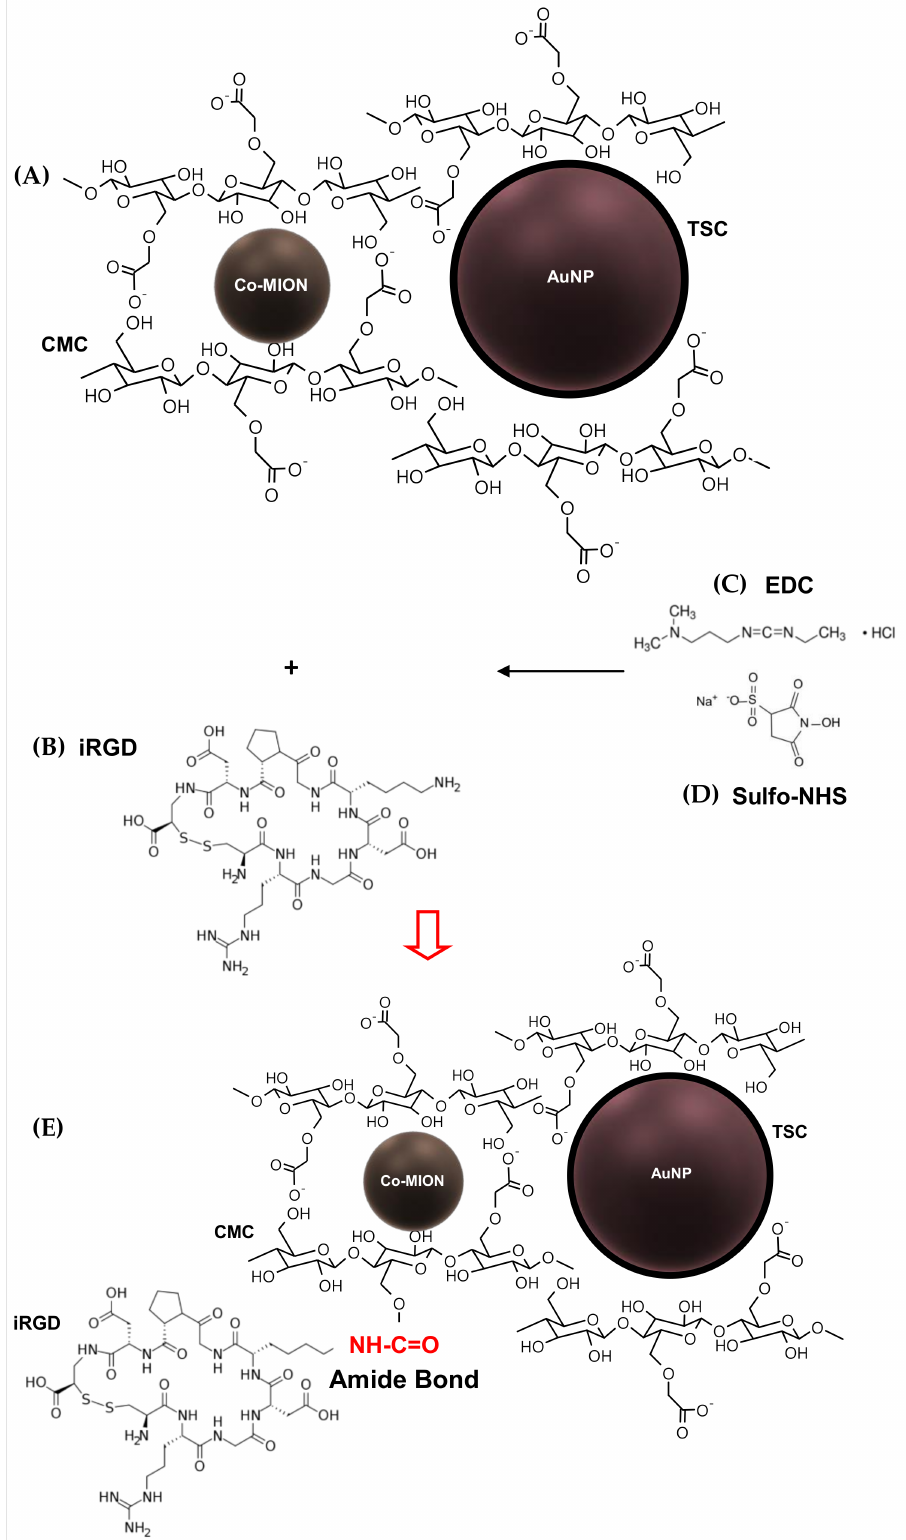
Figure 1. Chemical structure of biopolymer–peptide conjugate precursors: ( A ) inorganic–inorganic dual-nanozyme systems functionalized by a carboxymethylcellulose (CMC) biopolymer organic shell. ( B ) iRGD. ( C ) 1-ethyl-3-(3-dimethylaminopropyl)carbodiimide (EDC). ( D ) N-hydroxysulfosuccinimide sodium salt (sulfo-NHS). ( E ) active integrin-targeting hybrid catalytic